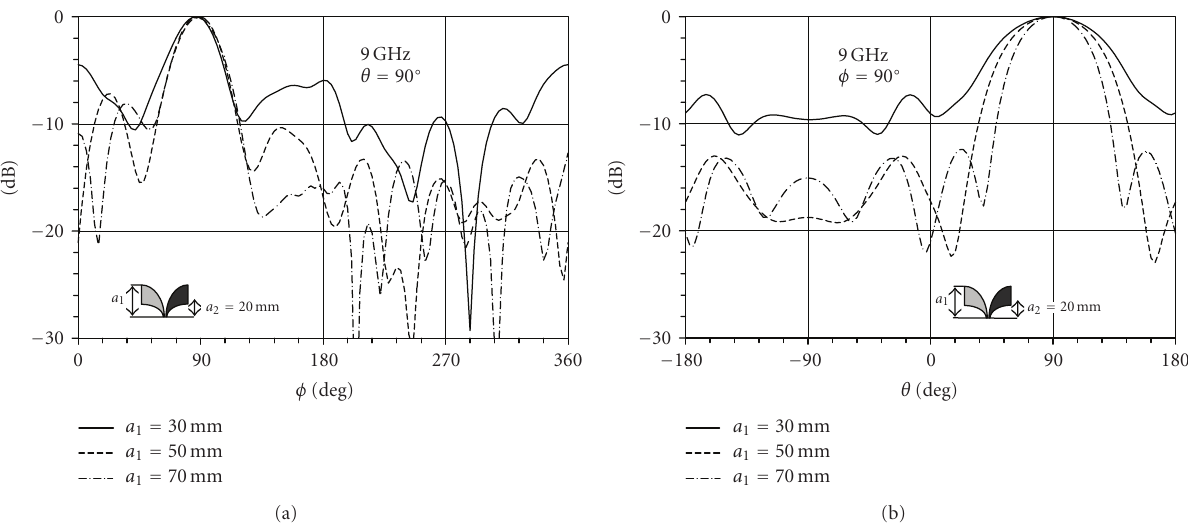
Figure 11: Radiation patterns of DETASAs for varying length of slot taper, a 1 , in (a) E-plane and (b) H-plane.